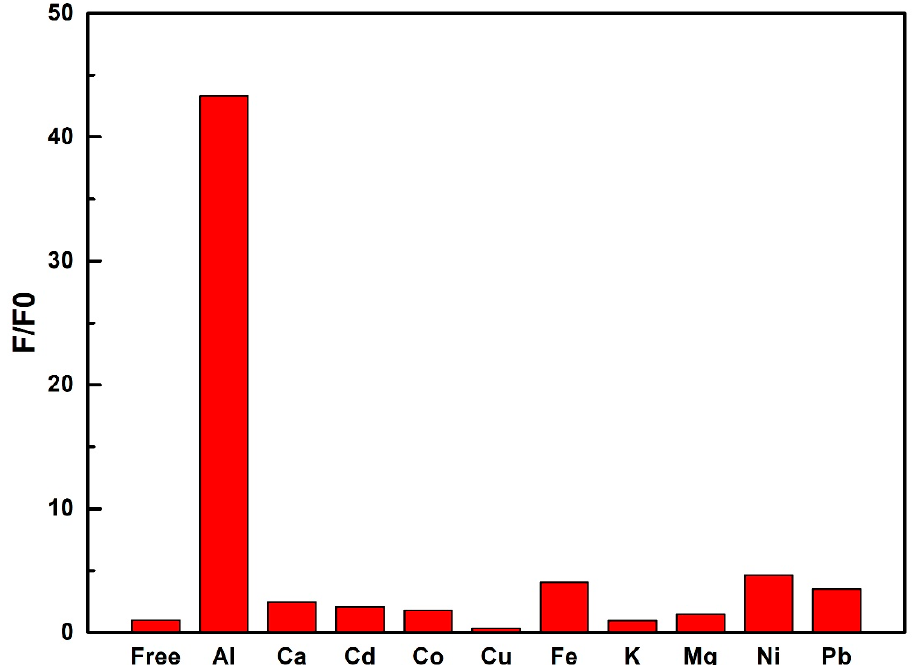
Figure 3. The luminescent intensity of compound 1 in DMF solution at 346 nm upon the addition of 2 equiv of AlCl 3 , CaCl 2 , CdCl 2 , CoCl 2 , CuCl 2 , FeCl 3 , KCl, MgCl 2 , NiCl 2 , and Pb(NO 3 ) 2 .